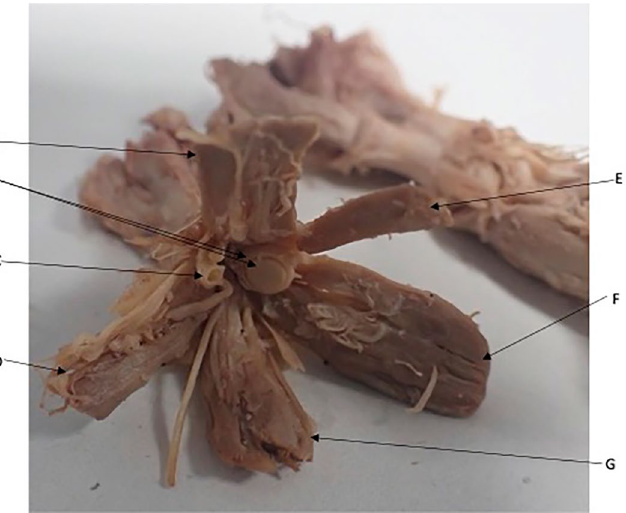
Figure 2. Anterior view of the extraocular muscles extending from a common tendinous origin. Optic nerve (B) containing within dural sheath and coursing through the common tendinous ring. Superior Rectus (A), Lateral Rectus (D), Levator Palpebrae Superioris, Medial Rectus (F), Inferior Rectus (G). Intra-orbital vessels (C).